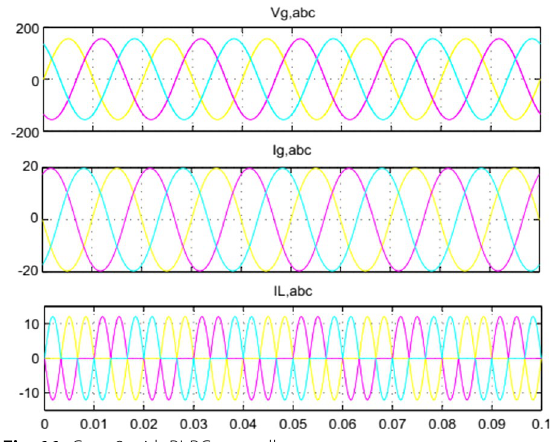
Fig. 13 Case-2 with ANFIS-PI controller